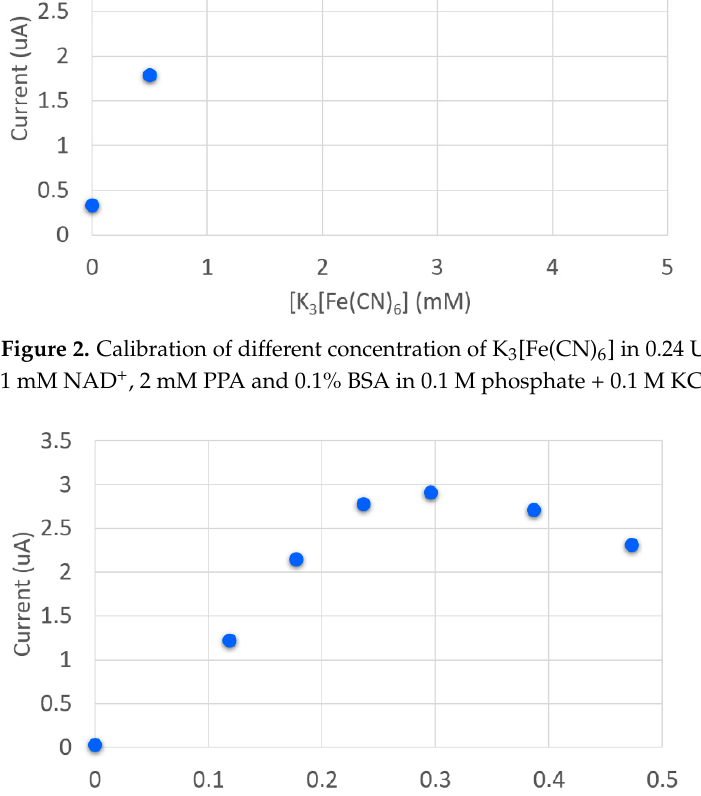
Figure 2. Calibration of different concentration of K 3 [Fe(CN) 6 ] in 0.24 U/mL ALDH, 0.24 U/mL DP, 1 mM NAD + , 2 mM PPA and 0.1% BSA in 0.1 M phosphate + 0.1 M KCl buffer solution pH 8.0.